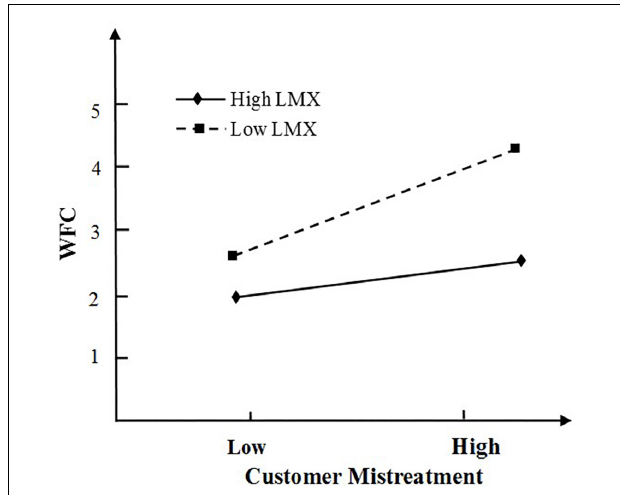
FIGURE 3 | Interaction between customer mistreatment and LMX on WFC.